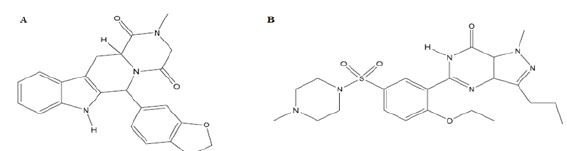
FIGURE 1 - Chemical structures of Tadalafil (A) and Sildenafil